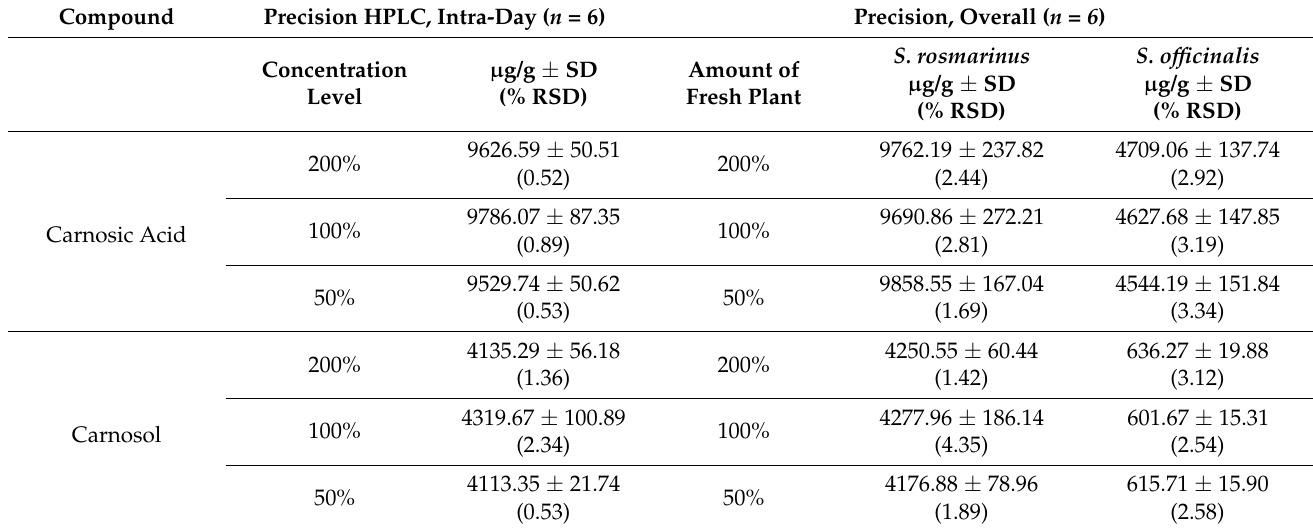
Table 2. Precision data of the HPLC method of the overall method (extraction included) expressed as µ g/g ± SD